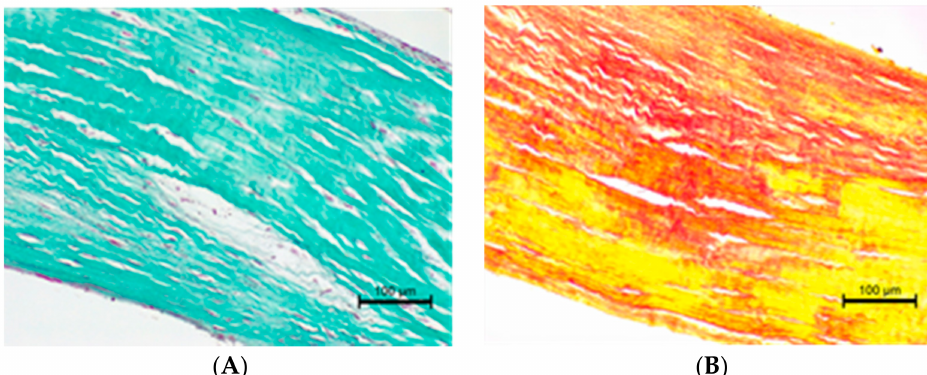
Figure 6. ( A ) Altered chorda tendinea from dog suffering from mitral valve disesase—disarrangement in collagen filaments is visible; Masson–Goldner trichrome stain; magnification 200 × . ( B ) Altered chorda tendinea from dog suffering from mitral valve disesase—disarrangement and absence of elastic filaments in some parts of the tissue is visible; elastic red–picrosirius stain; magnification 200 × . The orientation is the same as in Figure 5.